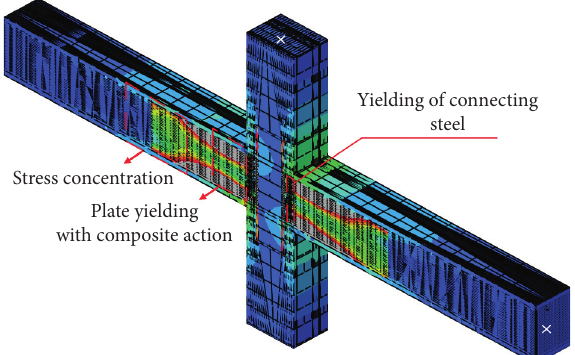
Yielding of connecting steel